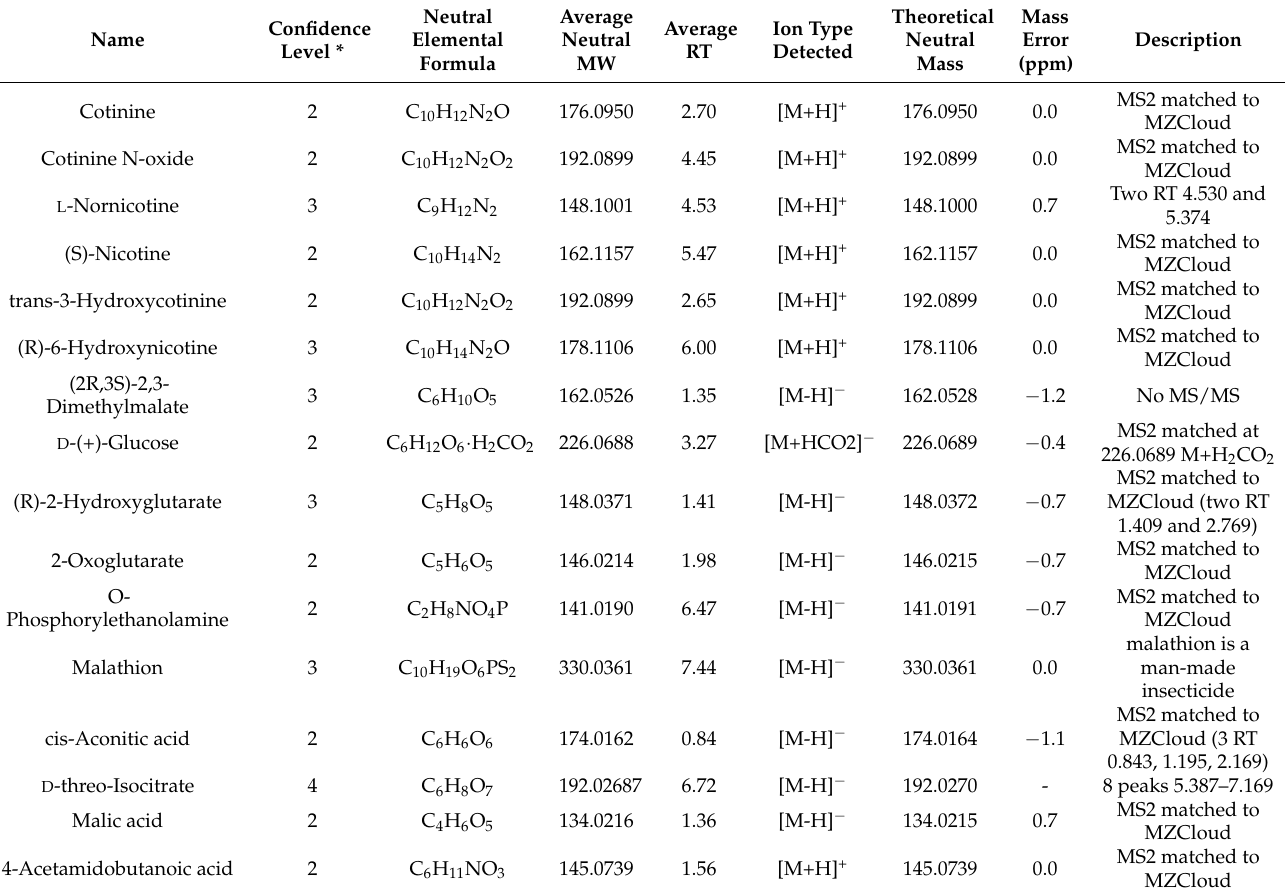
Table 3. Spectral (MS2) matching description of dysregulated